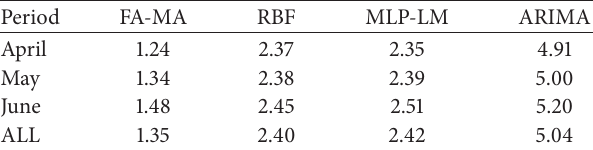
Table 7: MAPE of four forecasting models.